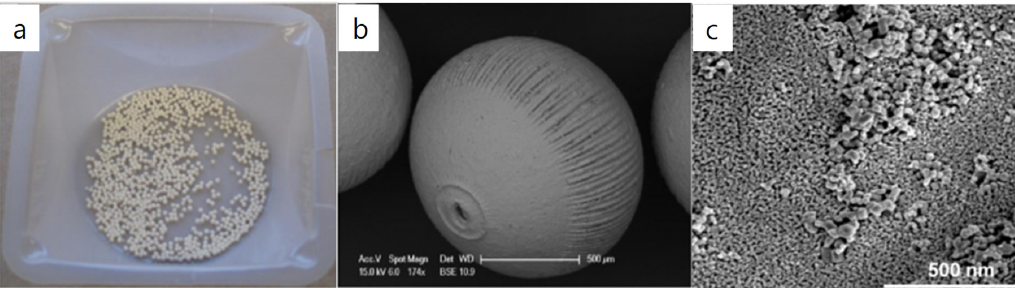
Figure 4. (a) The digital image and (b,c) SEM images of as ‐ obtained TiO 2 spheres, reprinted with permission from [97]. permission from